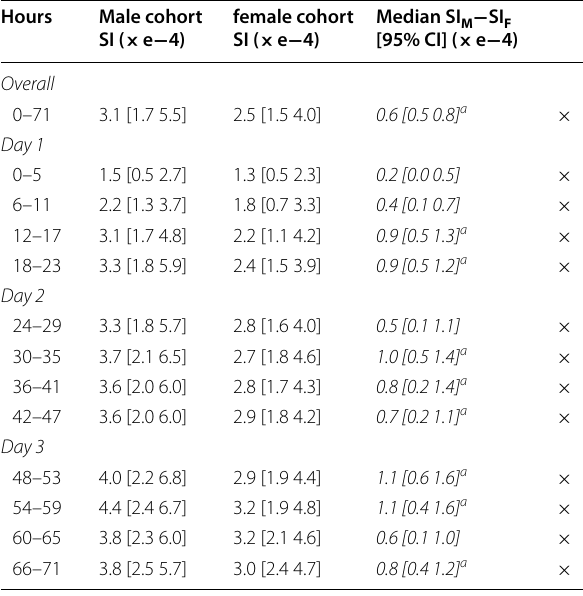
Table 2 Median [IQR] SI levels (L/mU/min) comparison for the first 72 h between male and female cohorts using 6-h